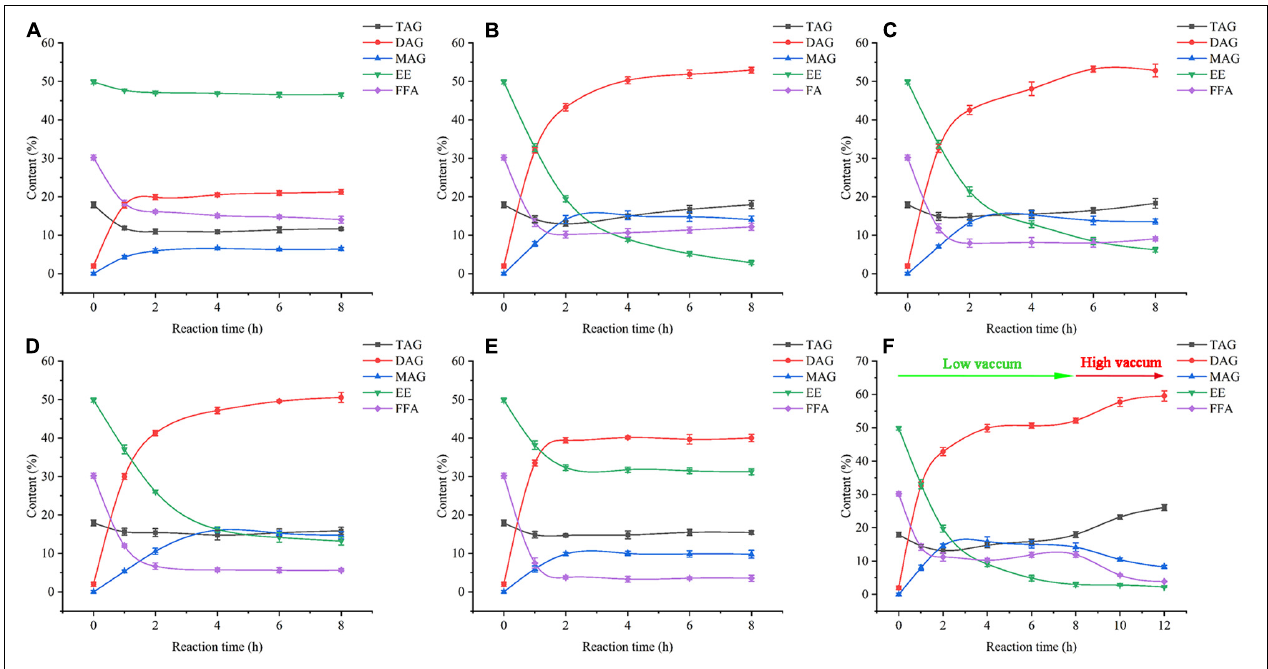
FIGURE 2 | Time course of lipid composition analysis under the condition of various vacuum (A) Atmospheric pressure, (B) 647 mmHg, (C) 497 mmHg, (D) 347 mmHg, (E) 47 mmHg, and (F) Two-step vacuum process). FFA: free fatty acid, EE: fatty acid ethyl esters, MAG: monoglyceride, DAG: diacylglycerol, TAG: